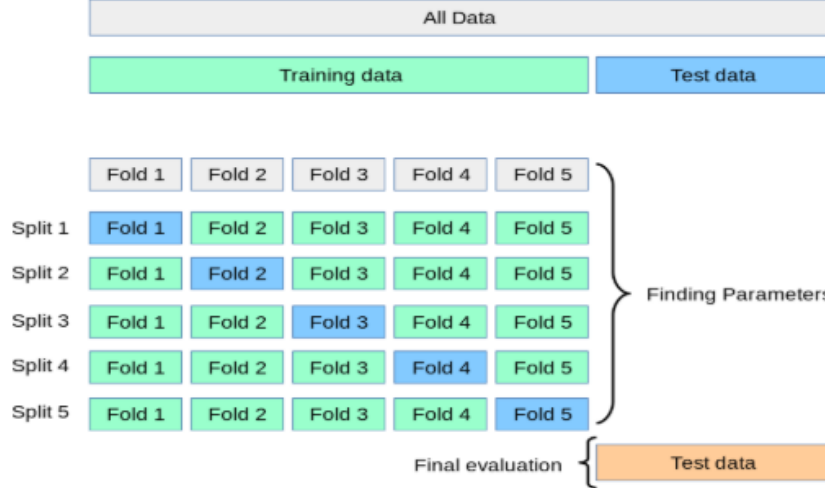
Figure 10. The illustration of a K-Fold cross-validation process [31].